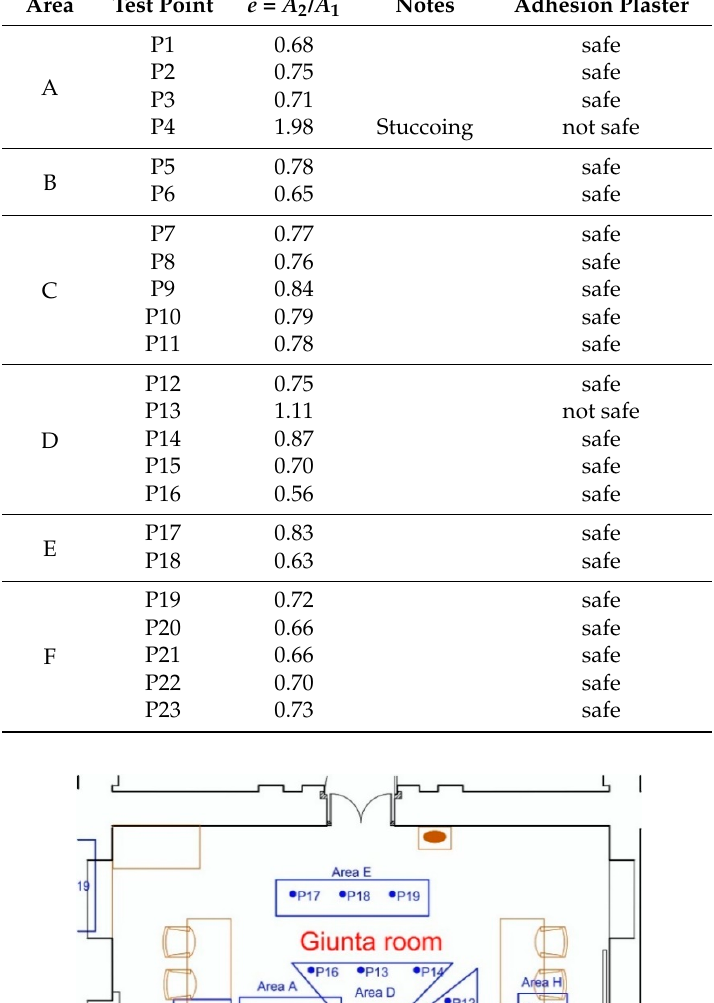
Table 2. Results of impact test on Blu room vault.